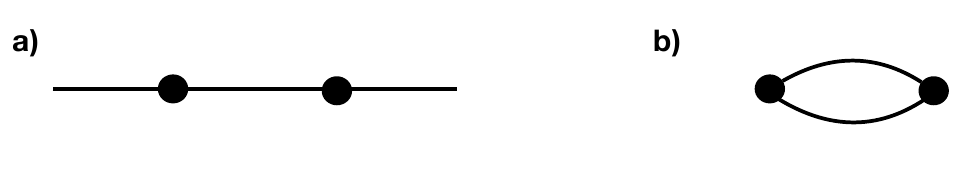
Figure 3. A long string configuration with two partons, corresponding to the zigzag model a), and a short closed “folded” string with two partons